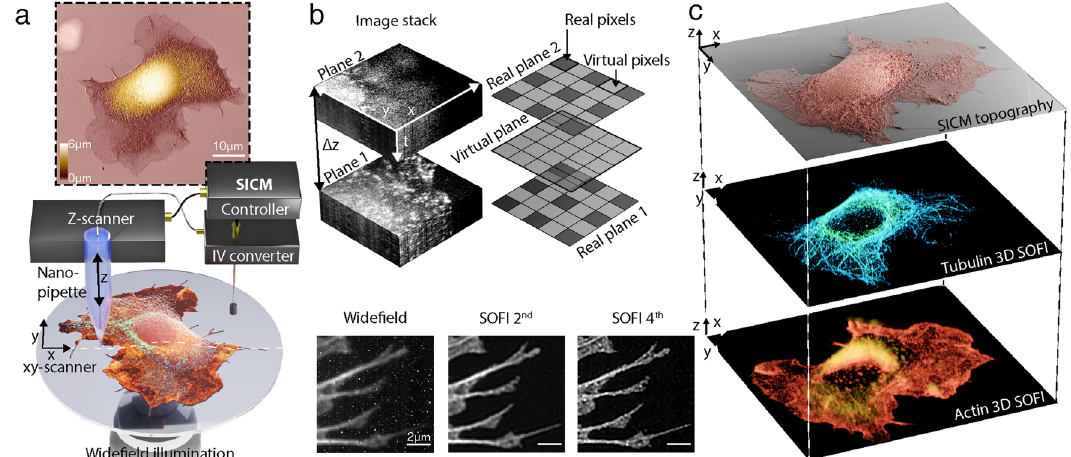
Fig. 1 Combined scanning ion conductance microscopy (SICM) and super-resolution optical fl uctuation imaging (SOFI) for three-dimensional topography- fl uorescence correlative imaging. a Schematic illustration of the SICM-SOFI setup. In SICM, a current is generated through a nanopipette and modulated as a function of the z-position. The image generated re fl ects a three-dimensional topographical view of the surface at high lateral and axial resolution (top panel). The lateral resolution in SICM ranges from 150 nm to 30 nm and the axial resolution is in the 10 nm range (Supplementary Fig. 1). Since the scanning head is mounted on top of the wide fi eld setup, fl uorescence imaging can be performed simultaneously. b Conceptual visualization of the SOFI principle. The recorded image stack, containing time traces of independently fl uctuating fl uorophores is used for analysis. A SOFI image is generated by computing cross-cumulants, creating virtual pixels between adjacent real pixels. The cross-cumulant computation principle can be applied in the axial direction as well if multiple sample planes are simultaneously acquired. For the n th order SOFI image, the cumulant point-spread function volume is raised ffiffiffi p n to n th power thus giving the resolution improvement of a factor of . The inset images of the actin structure at the bottom of the ( b ) panel represent a standard deviation of the image stack (wide fi eld), 2 nd and 4 th order of linearized SOFI images with corresponding lateral resolution values estimated with an image decorrelation-analysis algorithm of 420 nm, 194 nm, and 93 nm, respectively. c Schematics of correlative SICM and two-color 3D SOFI